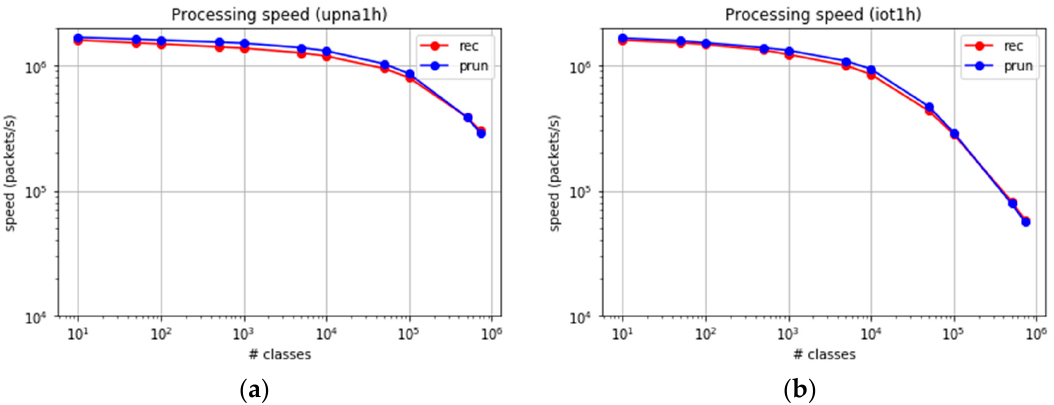
Figure 12. Packet processing speed for large sets of classes. ( a ) upna1h trace. ( b ) iot1h trace.